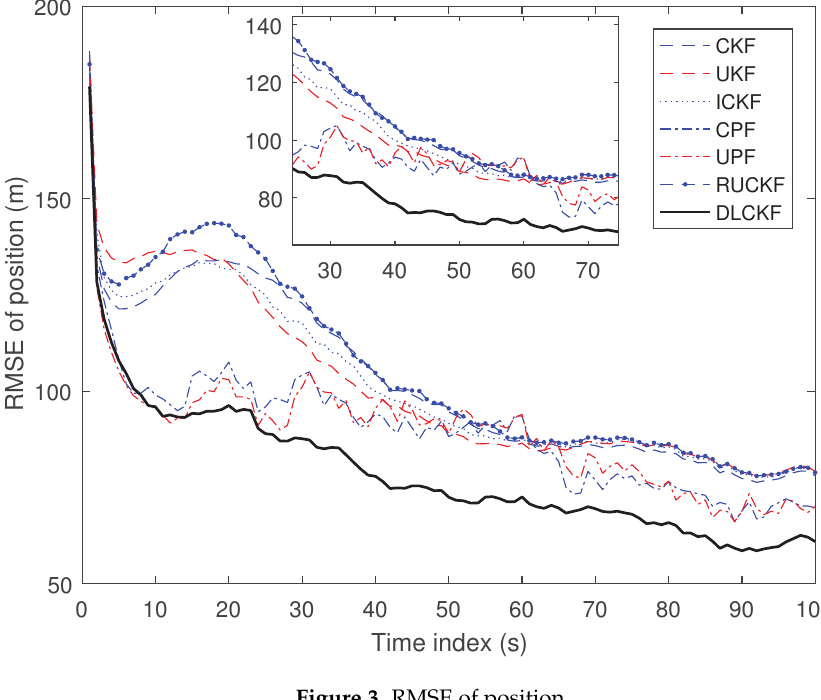
Figure 3. RMSE of position. Table 3. Performance of each